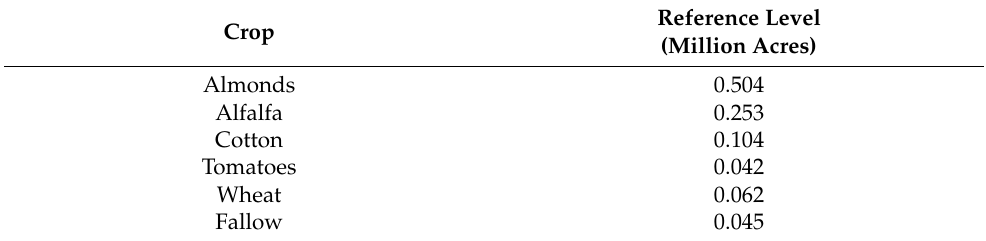
Table 2. Crop area reference levels for